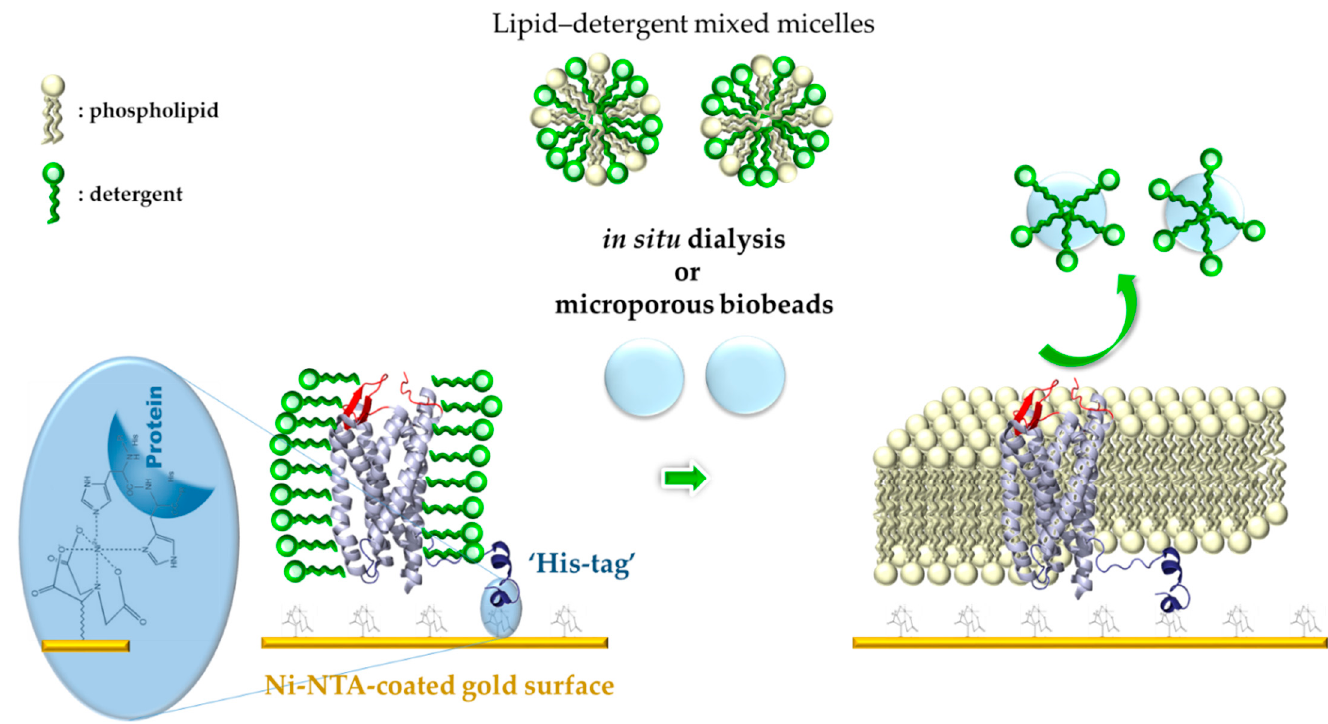
Figure 5. Principle of formation of protein-tBLMs or ptBLMs. A recombinant membrane protein with a ‘ His-tag’ in C- or N-terminus solubilized in detergent micelles is first attached by affinity to nitrilotriacetic acid (NTA) moiety grafted to a metal surface in the presence of Ni 2+ (or possibly Cu 2+ ) cations. The lipid bilayer surrounding the attached protein is obtained in a second step by in situ dialysis or using microporous biobeads in the presence of lipid–detergent mixed micelles (adapted with permission from [107]. Copyright 2004, American Chemical Society, and with permission from [132]. Copyright 2008, American Vacuum